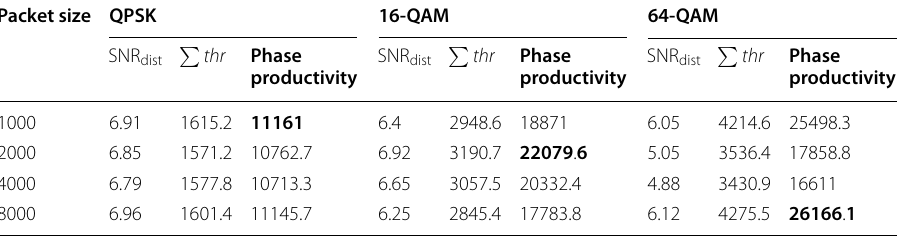
Table 10 Phase productivity for different packet sizes and modulations in the proposed CLLA model